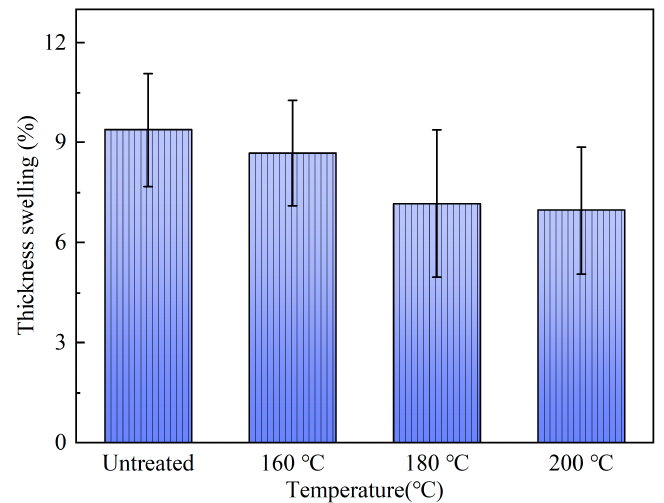
Figure 8. Thickness swelling of bamboo scrimbers after the artificial weathering test.